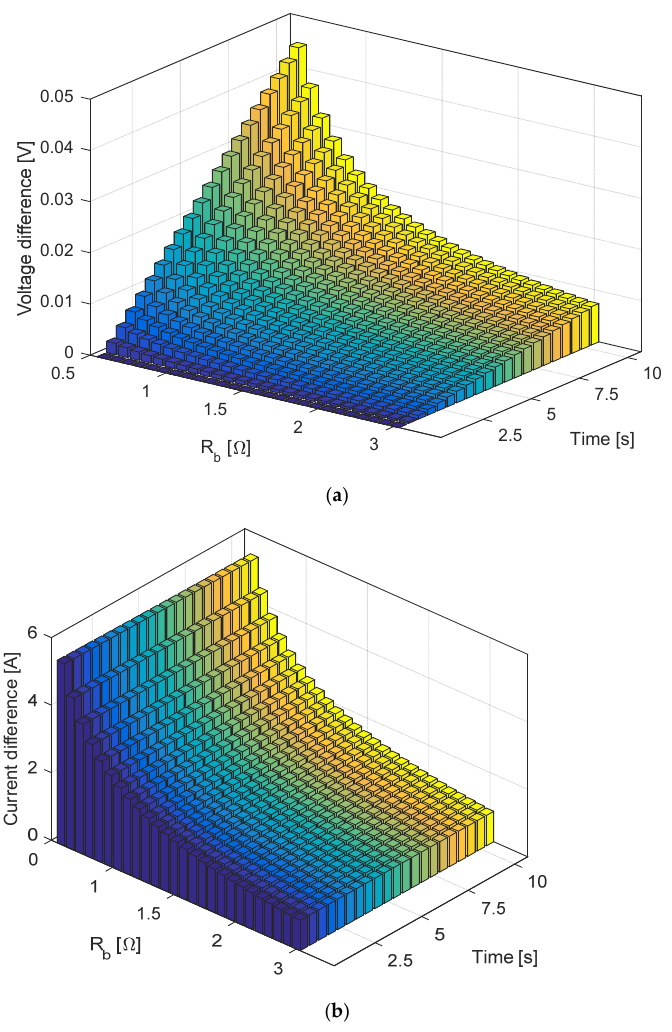
Figure 6. Differences in values of ( a ) voltages, and ( b ) currents, calculated using full expression derived in this study for small values of R b and the Calasan et al. method in [27], with infinite parallel resistance value, considering P = 50 W, and R = 0.58 m Ω .